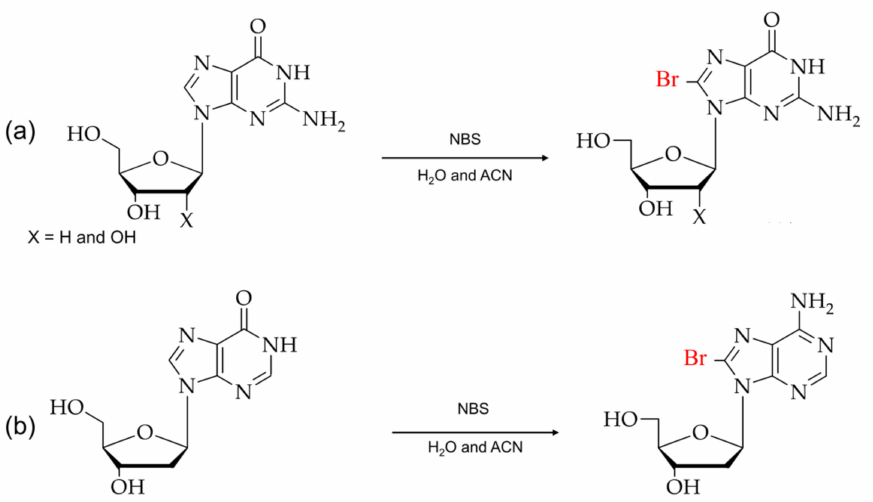
Figure 3. Typical brominations of purines: ( a ) 8-bromoguanosines and ( b ) 8-bromoadenosines with N-bromosuccinimide